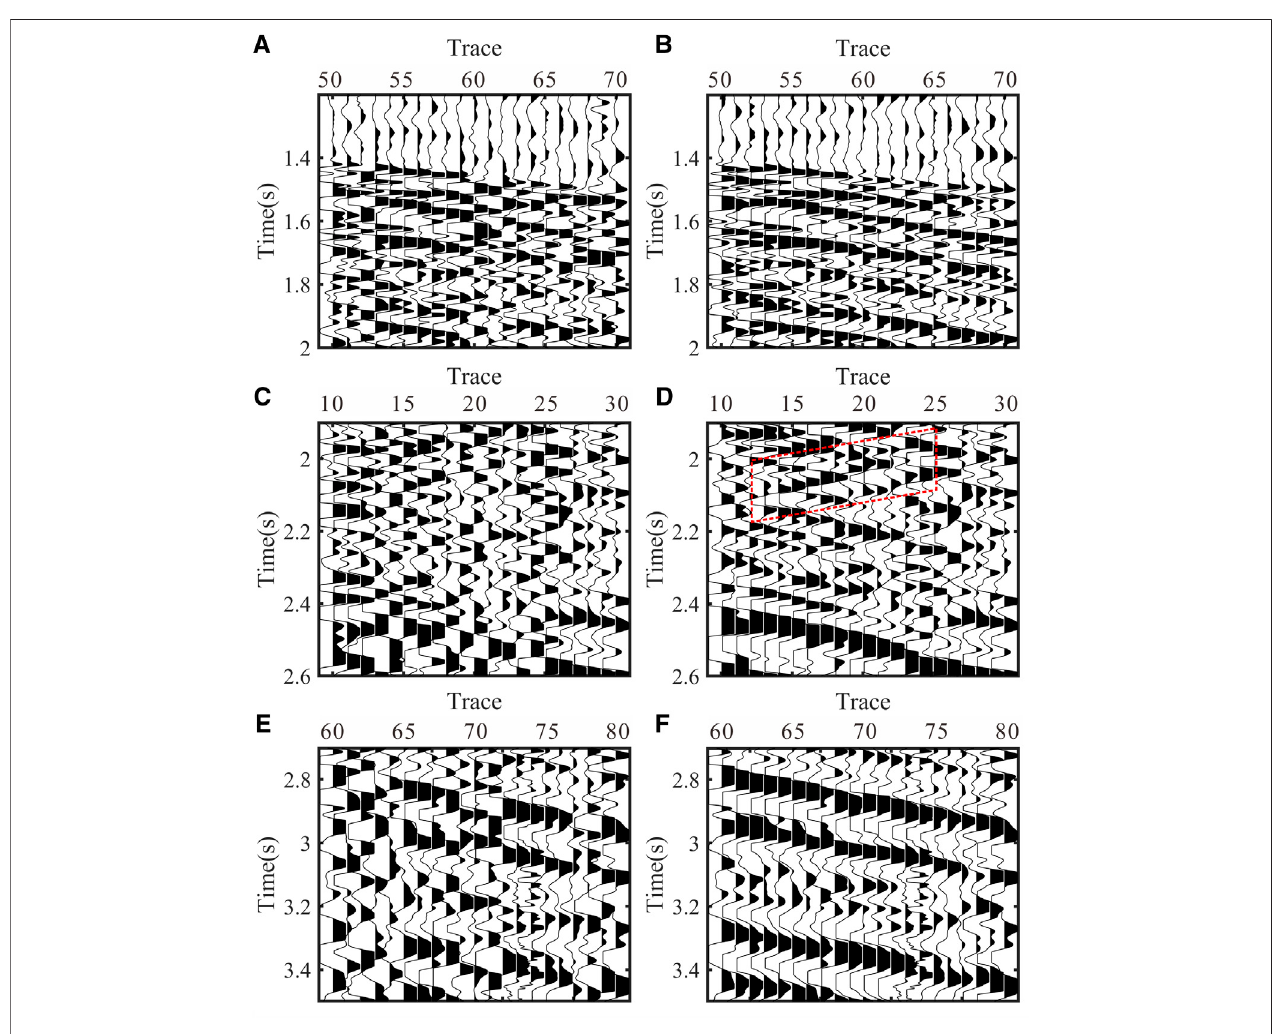
FIGURE 9 | Typical wave fi elds of fi eld seismic data after rotation. (A), (C) , and (E) : VSP data generated by the eigenvalue method. (B), (D) , and (F) : VSP data generated by the scalar fi eld method.